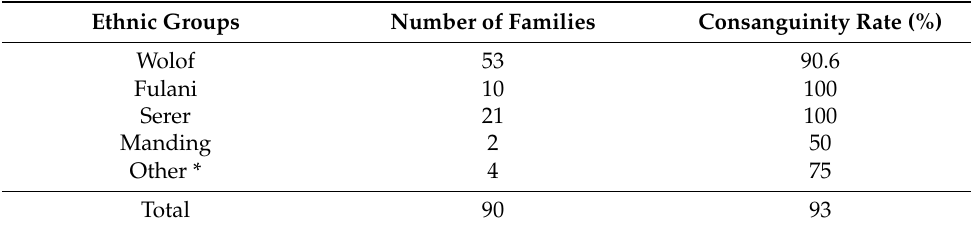
Table 4. Consanguinity rate among the main ethnic groups. Ethnic Groups Number of Families Wolof